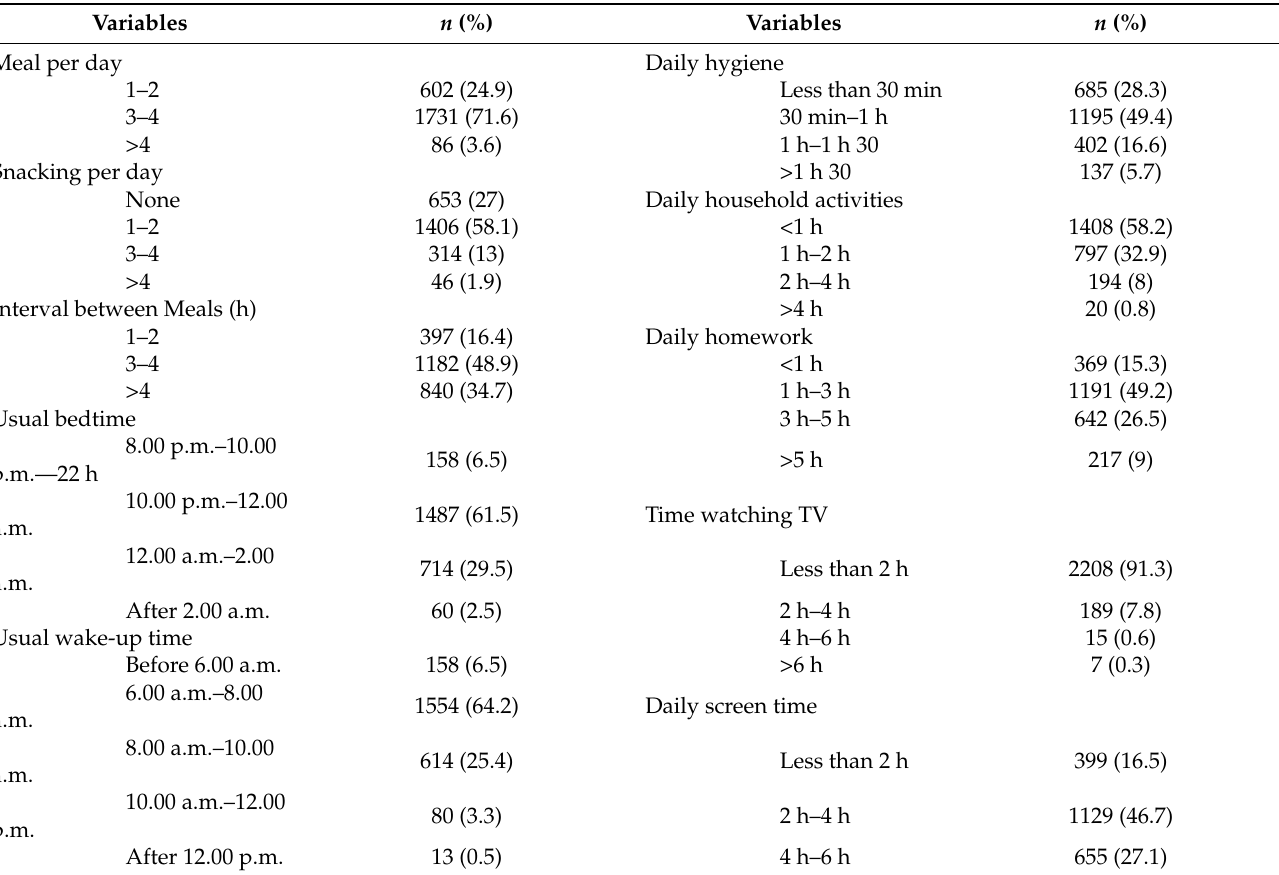
Table 2. Frequencies of lifestyle habits in college students participating in the